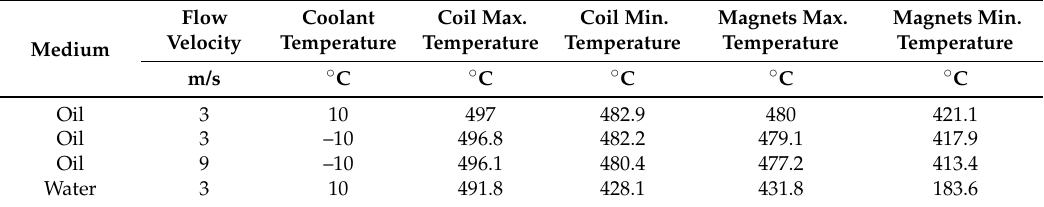
Table 2. Temperature of oil cooled EMAT against flow velocity and oil temperature.